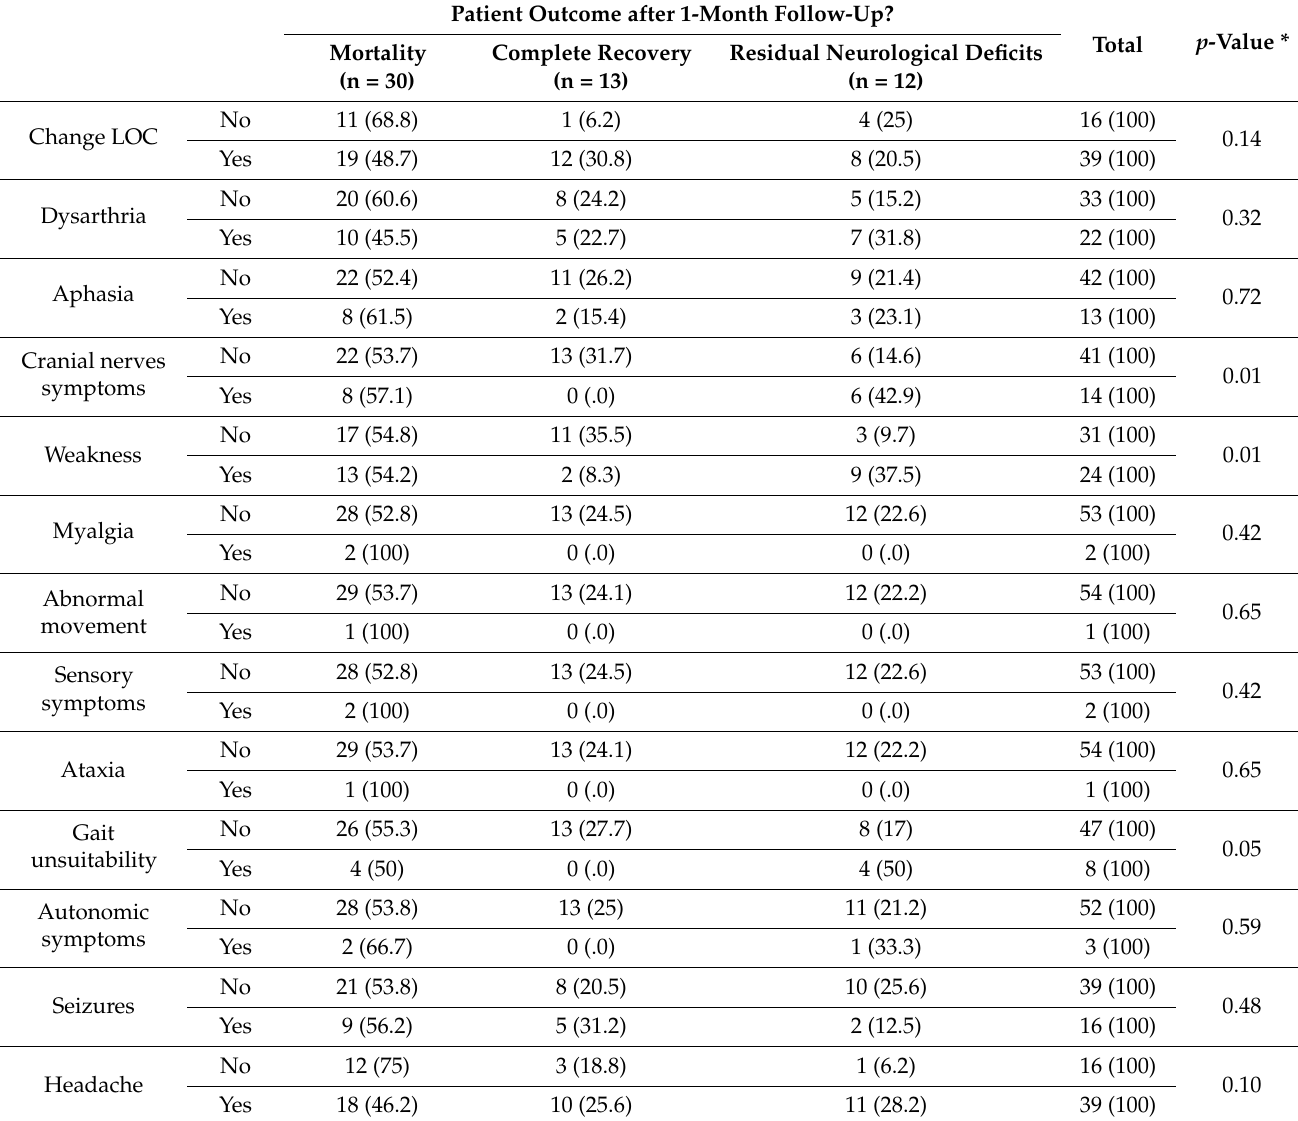
Table 2. Relation of patient outcomes with the neurological symptoms.